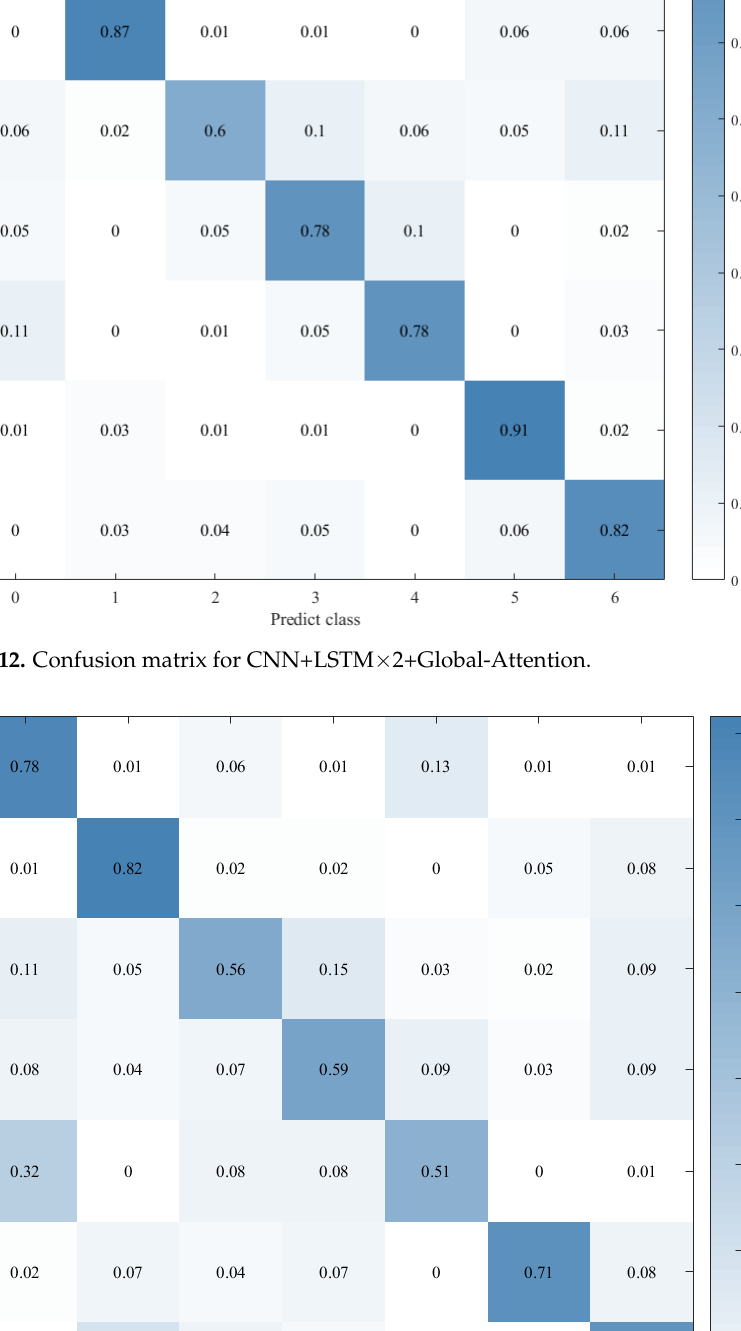
Figure 14. Confusion matrix for CNN+LSTM×2.